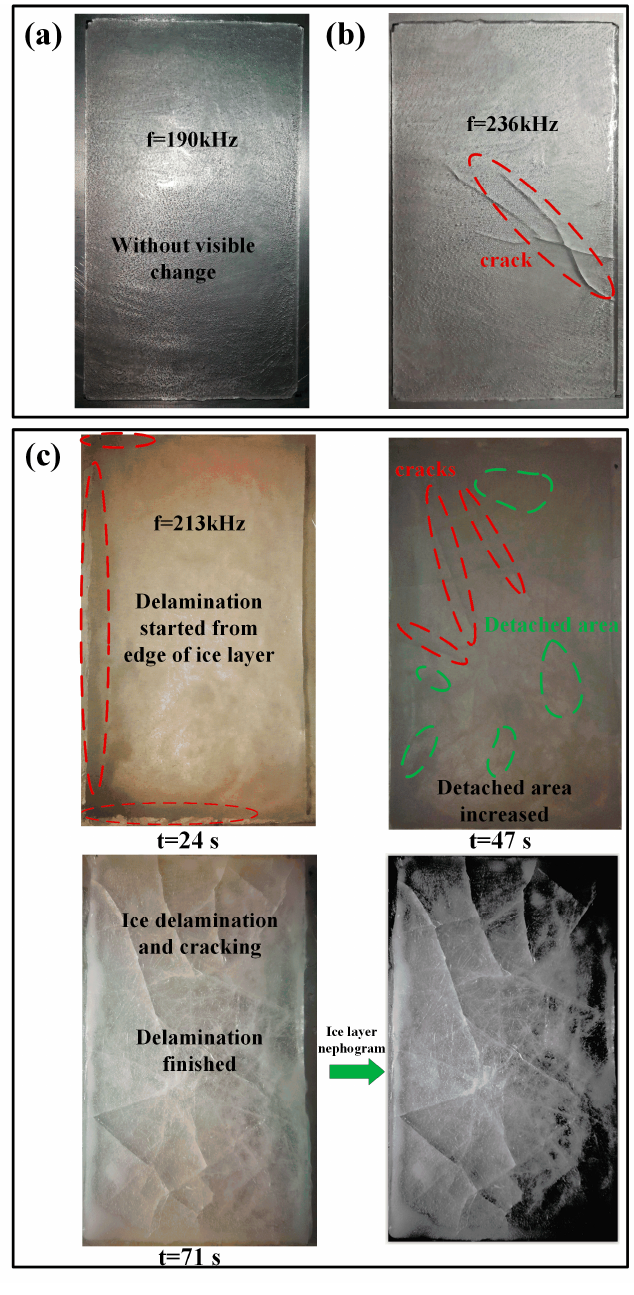
Figure 18. Deicing effects for different frequencies.